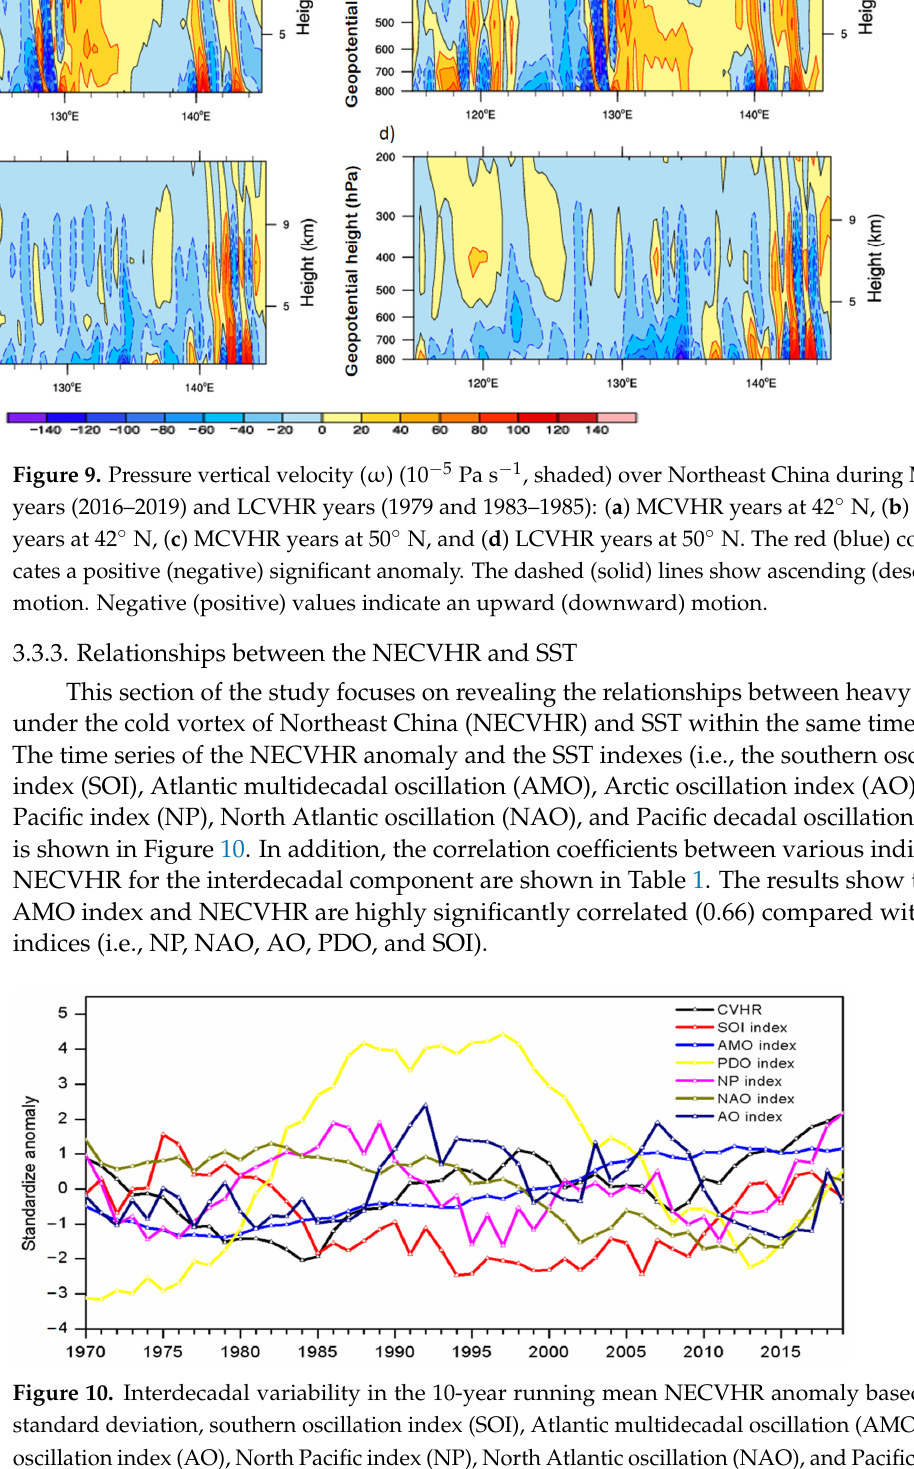
Figure 8. Relative humidity (shaded) and wind (m/s, vectors) components at 850 hPa for the two rainfall patterns in Northeast China during 1961 − 2019: ( a ) pattern A; ( b ) pattern B; areas reaching 95% significant test are dotted; the red box marks the differences.